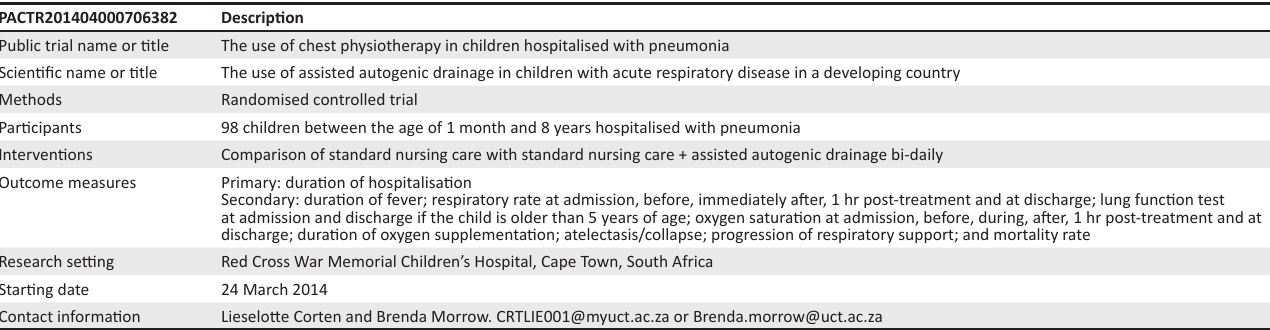
TABLE 1-A1: Characteristics of ongoing